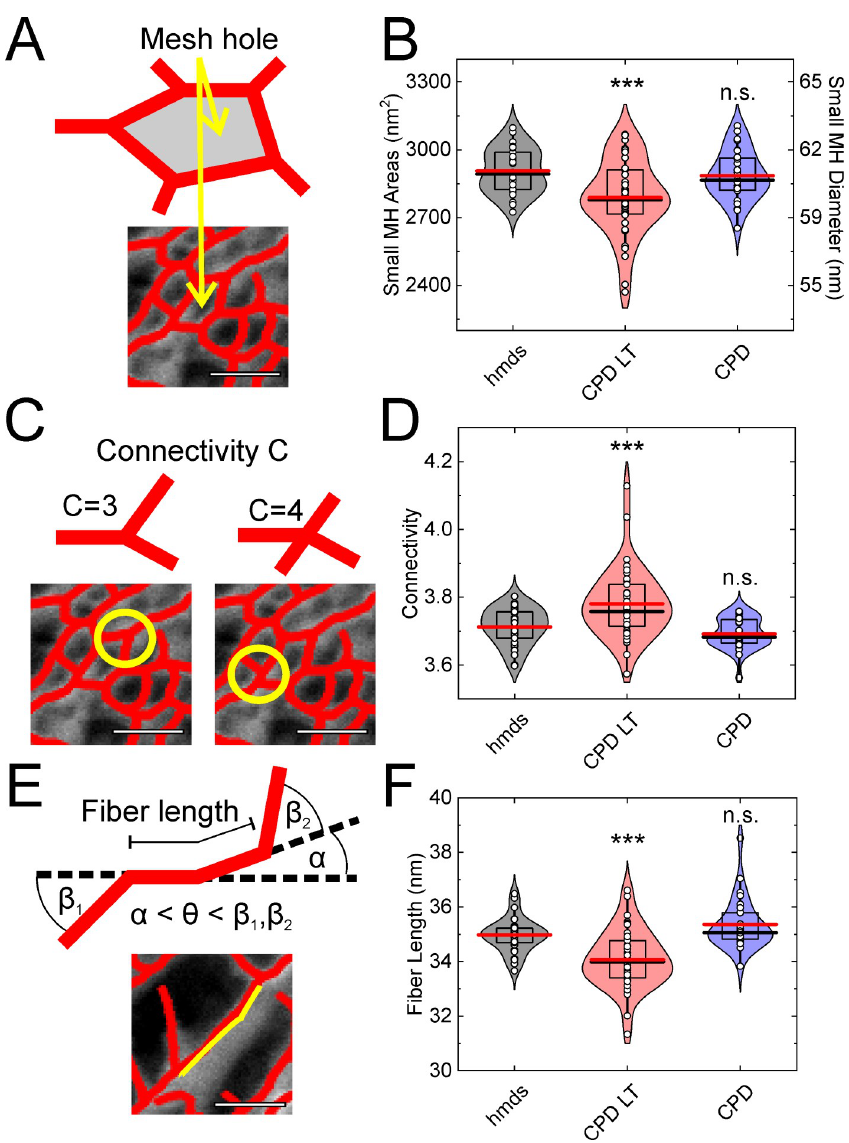
Fig 4. Mesh hole size, connectivity, and fiber length analysis using the vector tracing software. ( A - C ) Schematic representations of the mesh hole size (A), connectivity (B), and fiber length (C) measures for the cellular actin network. ( D - F )Quantification of the vector tracing software data for HMDS10 drying (hdms), and CPD-LT and CPD, for the mesh hole (MH) size (D; < 100 nm; i.e., excluding artifactual mesh holes), connectivity (E), and fiber length (F). Scale bars: 100 nm (A, C, E). ��� p < 0.001, n.s. not significant; each data set was compared to hmds (B, D, E) using t-tests. ANOVA tests: p = 7.43 � 10 − 4 (B), p = 1.42 � 10 − 5 (D), p = 3.7 � 10 − 7 (F). N = 29, 39, 28 (B, D, F, from left to